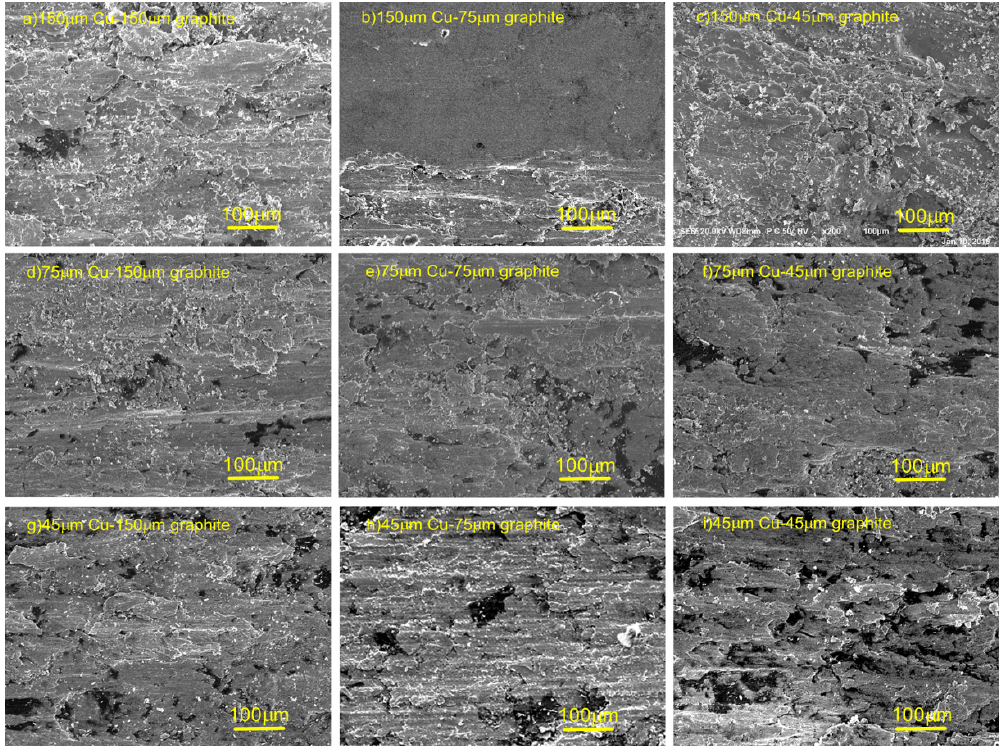
Figure 8. SEM photographs of the mechanical wear area of composite materials: ( a ) 150 μ m copper–